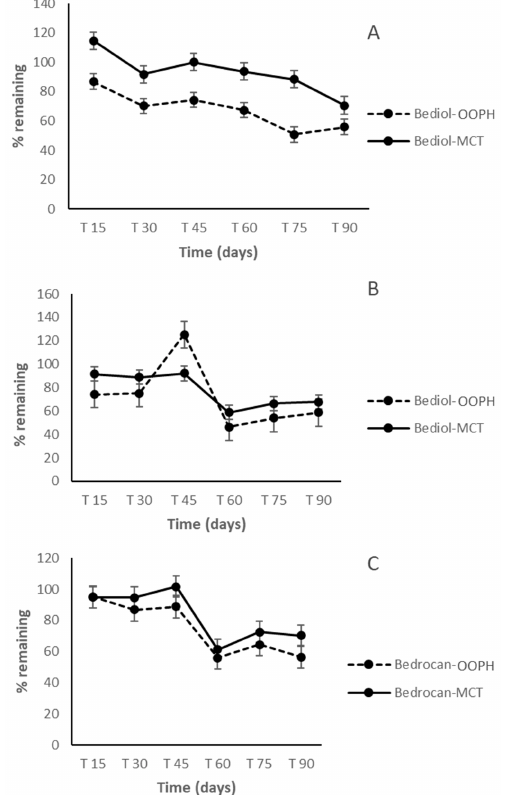
Figure 4. CBDA (cannabidiolic acid) trends in Bediol ® ( A ), ∆ 9 -THCA in Bediol ® ( B ) and Bedrocan ® ( C )-based oils as a function of storage time and lipid sources: PhEur-grade olive oil (OOPH) and medium-chain triglycerides (MCTs).